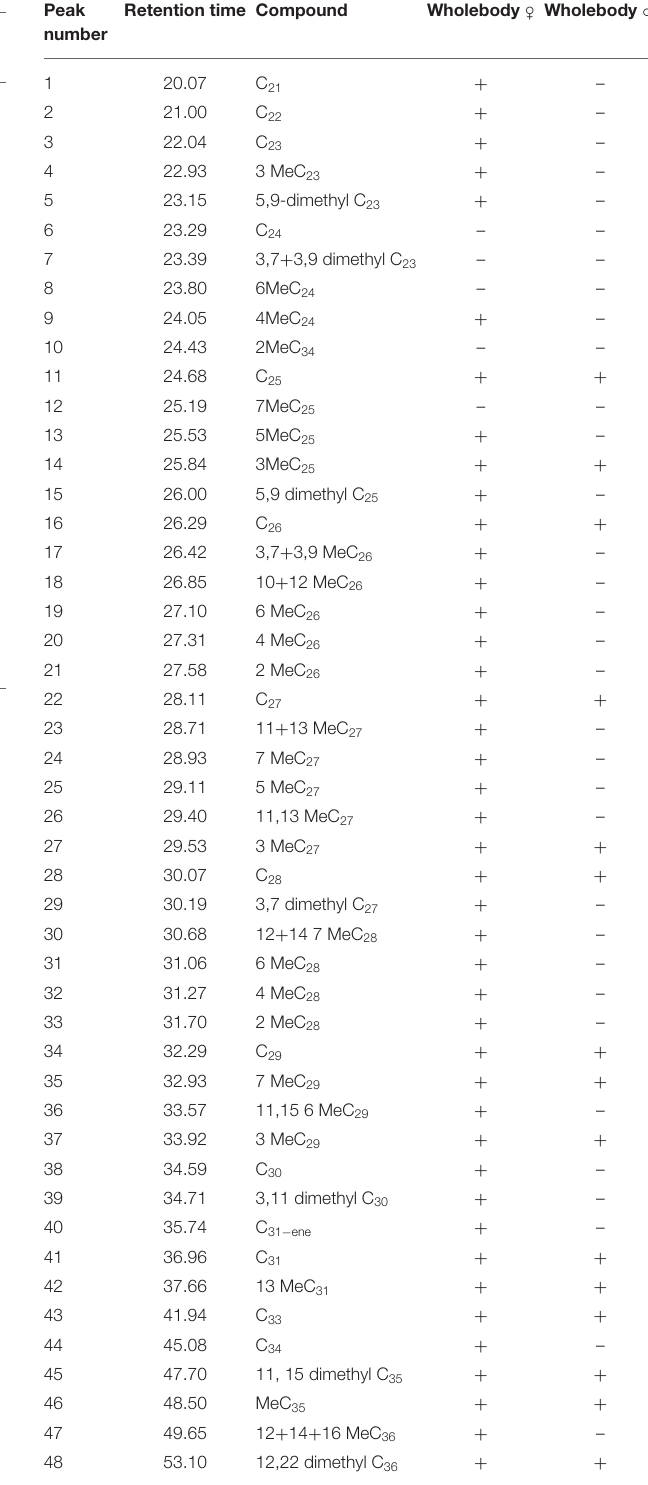
TABLE 1 | Peaks produced by the hexane extracts of resin copies obtained by the pronota of sexually mature male and female pronota in 2014, and by the pronota of attracted males and attractive females in 2015.